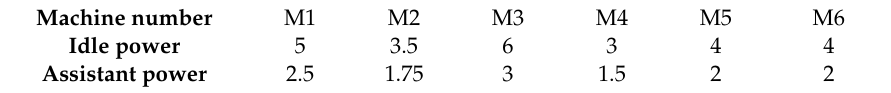
Table 1. Idle power and assistant power data for the machines.